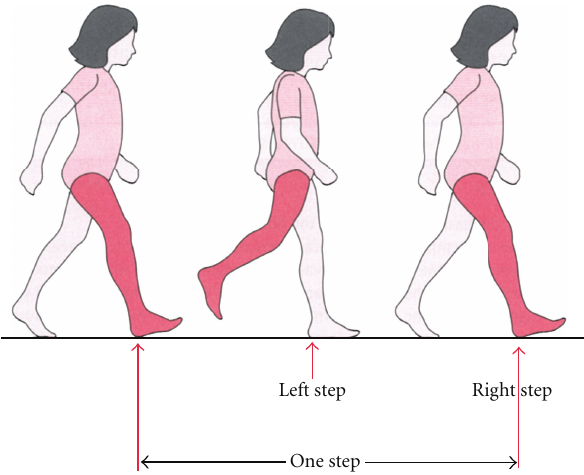
Figure 1: One gait cycle, or stride, is defined as two consecutive heel strikes of the same limb. Each gait cycle is composed of two steps. Reprinted with permission: Elsevier Books (2857691435547).